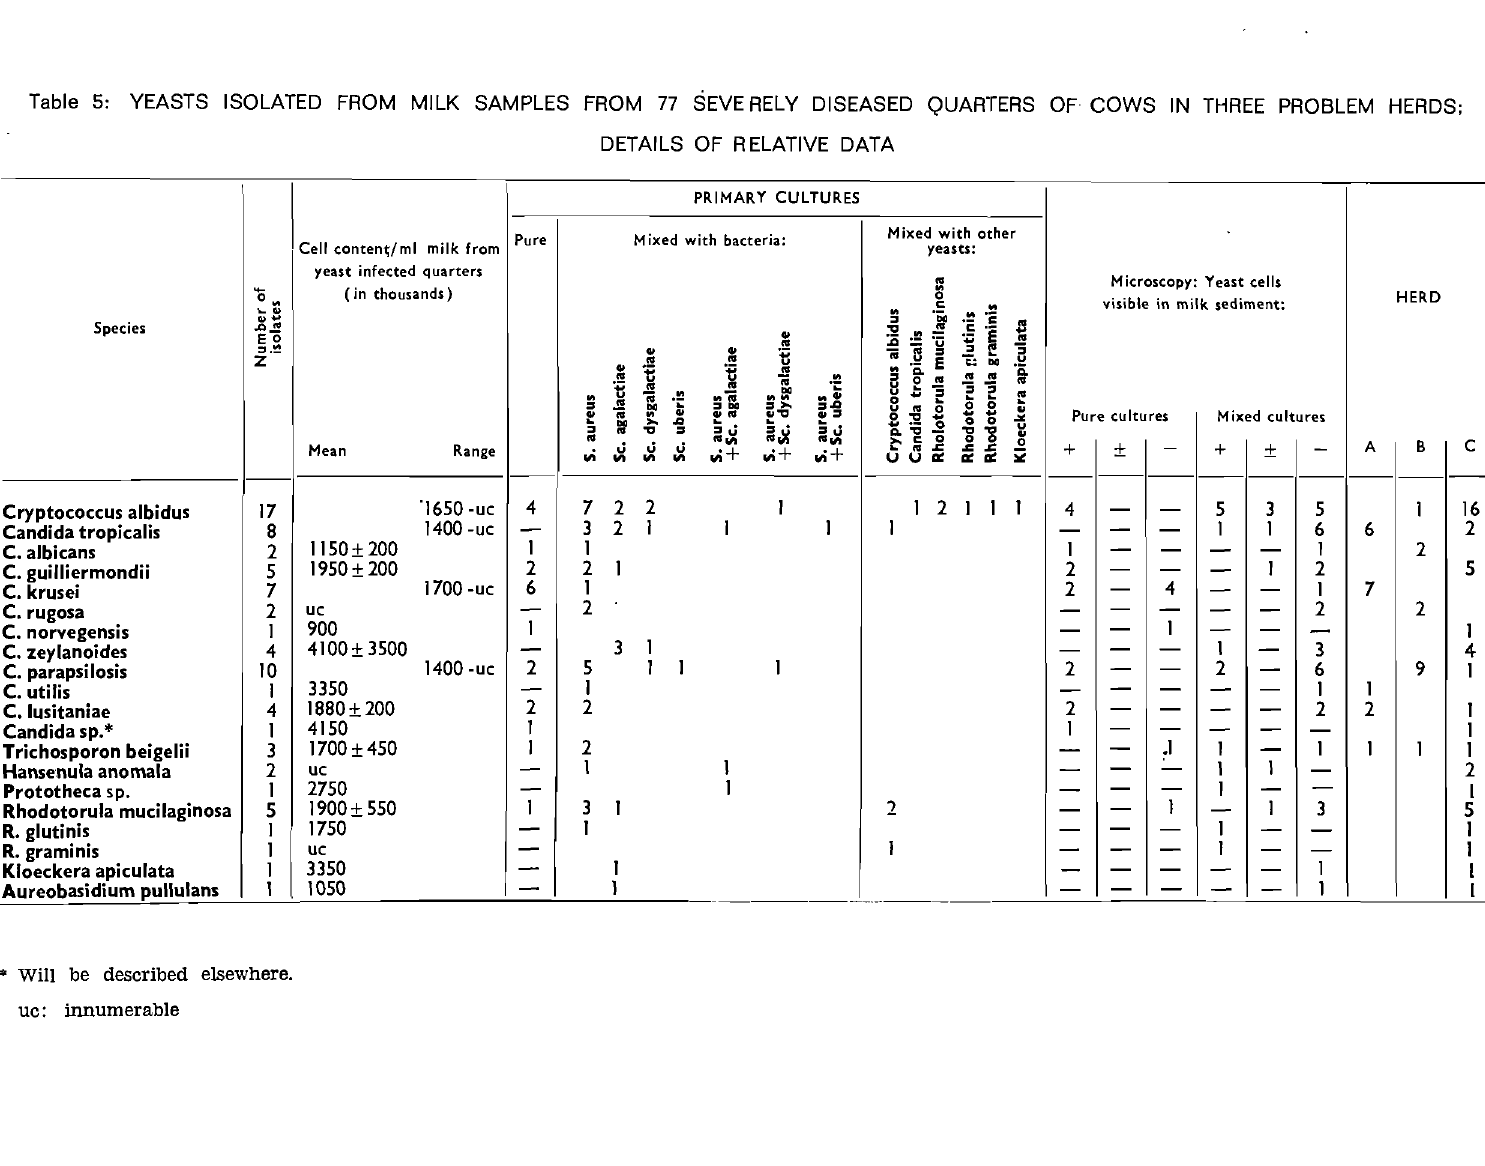
Table 5: YEASTS ISOLATED FROM MILK SAMPLES FROM 77 SEVE RELY DISEASED QUARTERS OF COWS IN THREE PROBLEM